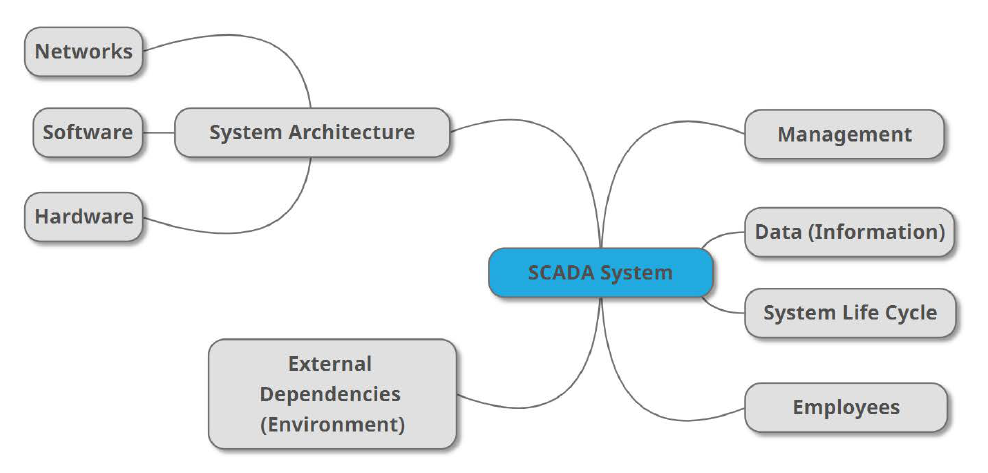
Figure 2. Top-Level Entities of the Unified Mind Map of a SCADA